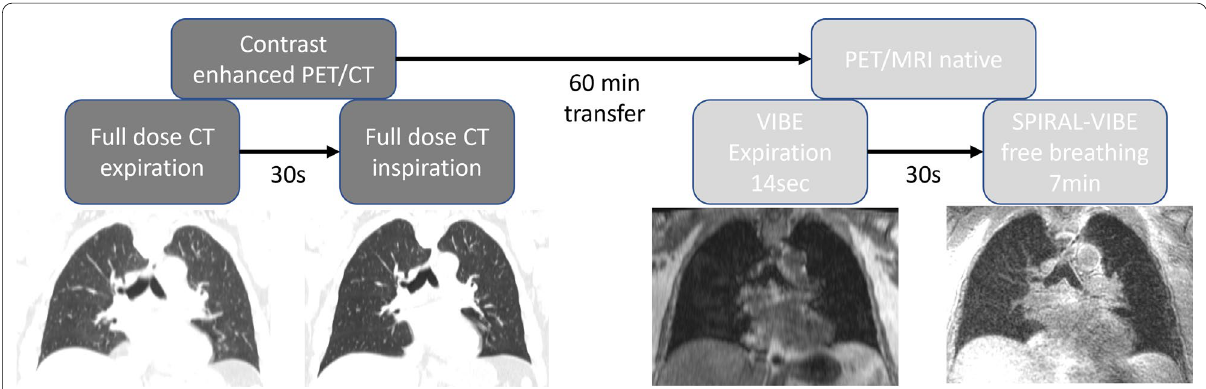
Fig. 1 Flowchart of examination sequence in integrated PET/CT and PET/MRI